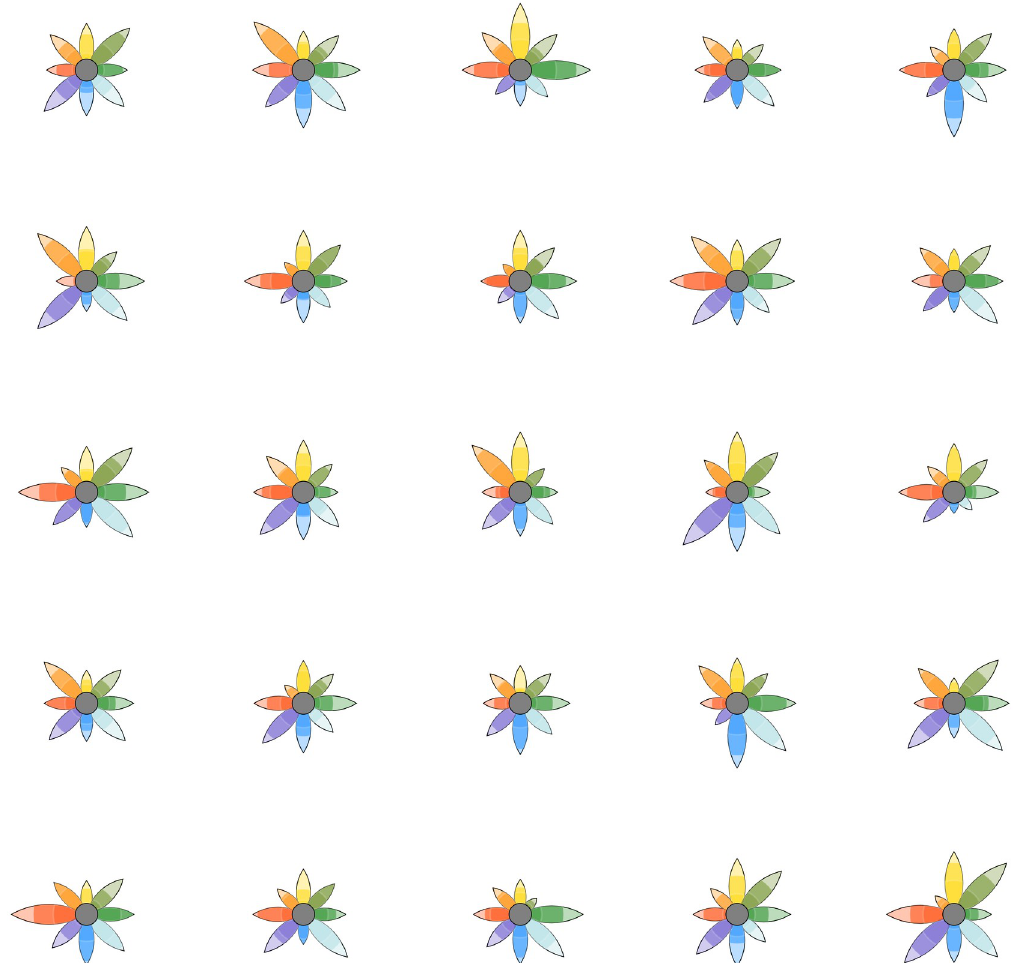
Fig 6. Small-multiple of a series of Plutchik’s wheel built from synthetic data. Polar coordinates beneath the flowers and labels around have been hidden to improve the immediate readability of the flowers, resulting in a collection of emotional fingerprints of different